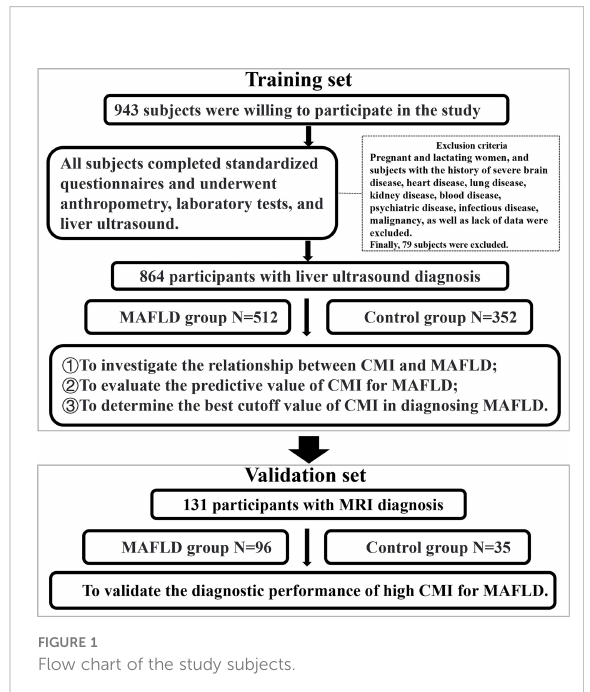
FIGURE 1 Flow chart of the study